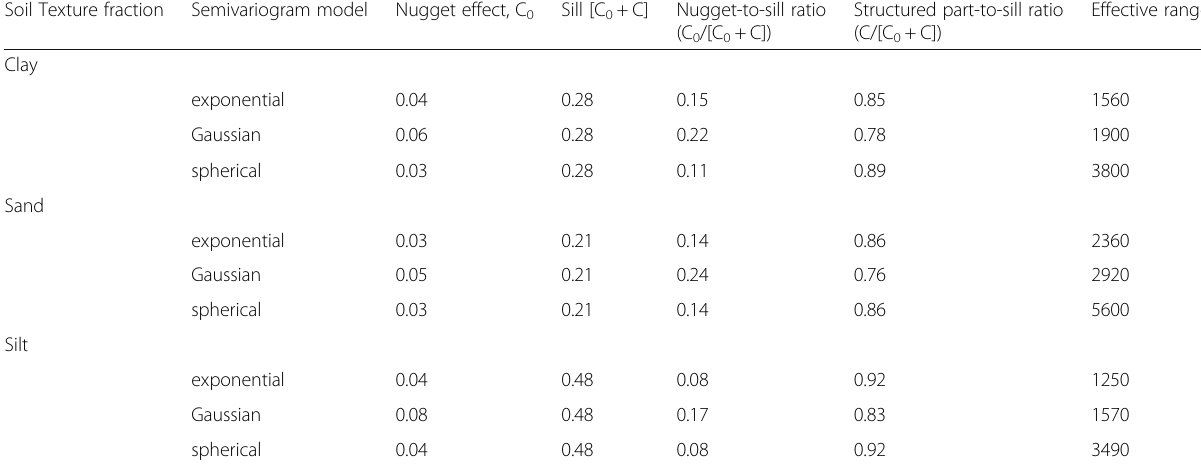
Table 4 The variogram parameters of soil texture fractions applying exponential, Gaussian and exponential models Soil Texture